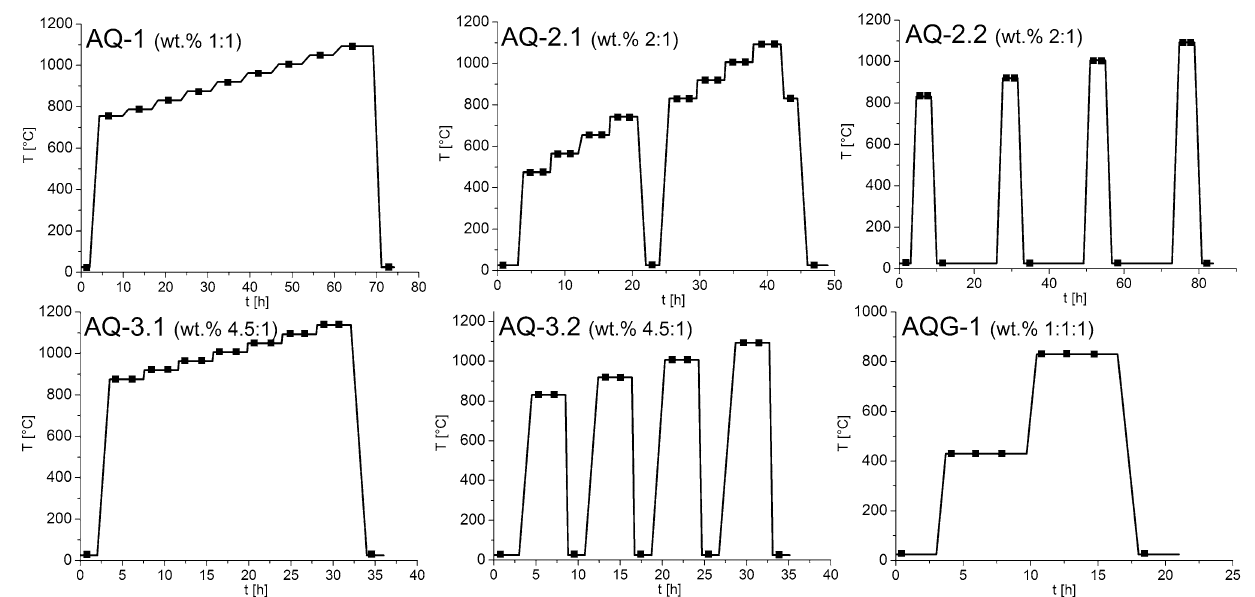
Fig. 1 Temperature histories of the in situ and the in situ/quench experiments. (In the in situ/quench experiments the sample was fired to the sintering temperatures and two hyperspectral Raman images were subsequently recorded. Afterwards the sample was quenched to RT before a last Raman image was recorded. In the in situ experiments, the green bodies were progressively fired to higher temperatures and Raman images were recorded in situ. Squares represent the start of each